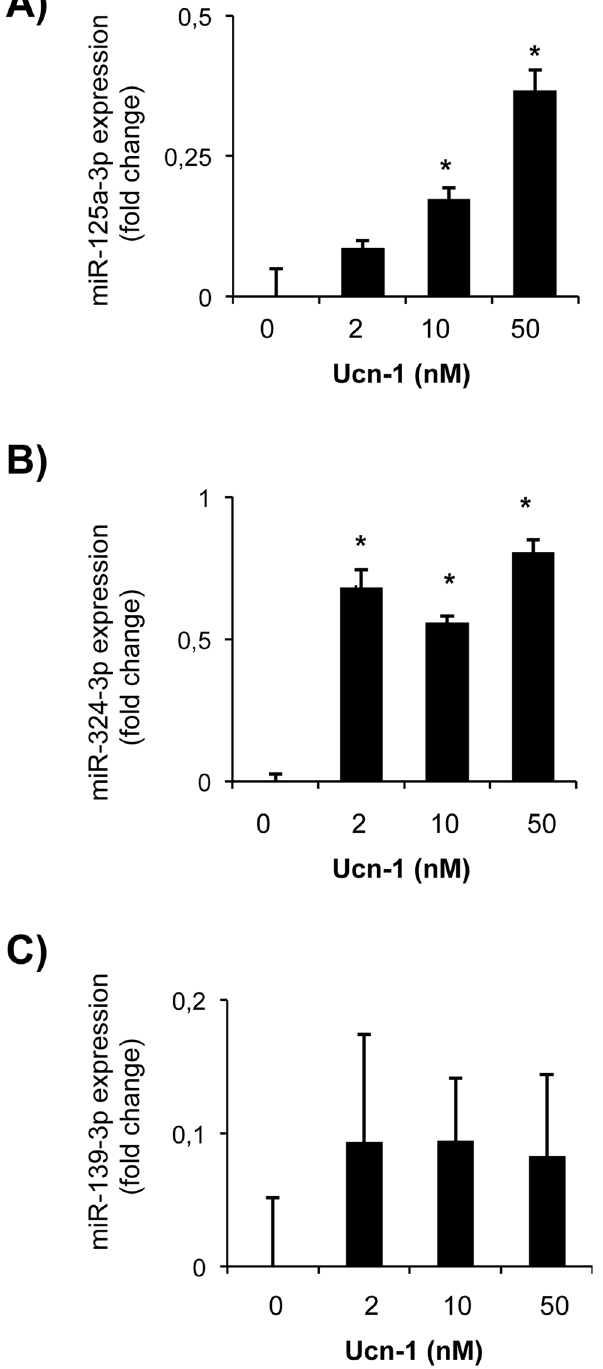
Figure 3. Urocortin-1 regulates miR-125a-3p, miR-324-3p and miR-139-3p expression in isolated cardiac myocytes. Bar graphs showing fold changes in the expression of miR-125a-3p ( A ), miR-324-3p ( B ) and miR- 139-3p ( C ) in isolated cardiac myocytes treated 10 minutes with increasing concentrations of Ucn-1 (2, 10 and 50 nM). Values are means ± S.E.M, (n = 4). “ * ” indicates significance at p <